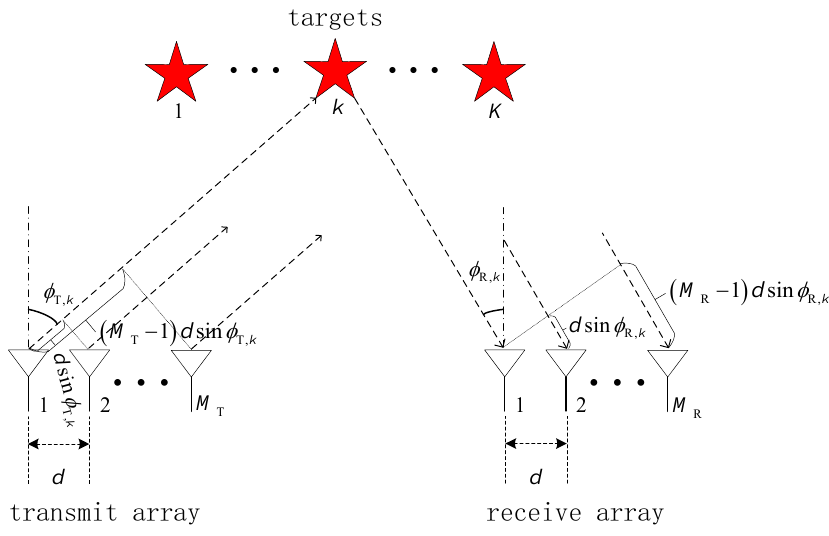
Figure 1. Schematic illustration of the considered bistatic MIMO